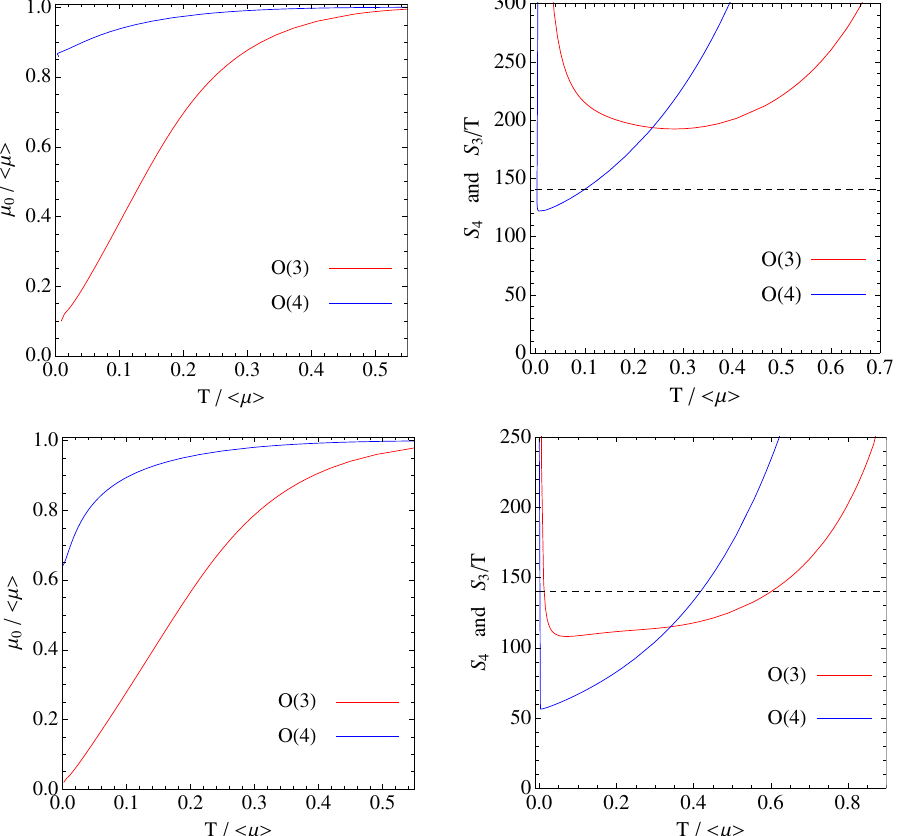
Figure 6 . Upper panels: as in (cid:12)gure 4 but for scenario C 2 . Lower panels: as in (cid:12)gure 4 but for scenario C 1 . The (cid:12)ndings are qualitatively similar to those arising in the most common parameter scenarios where the back-reaction is large (cf. (cid:12)gure